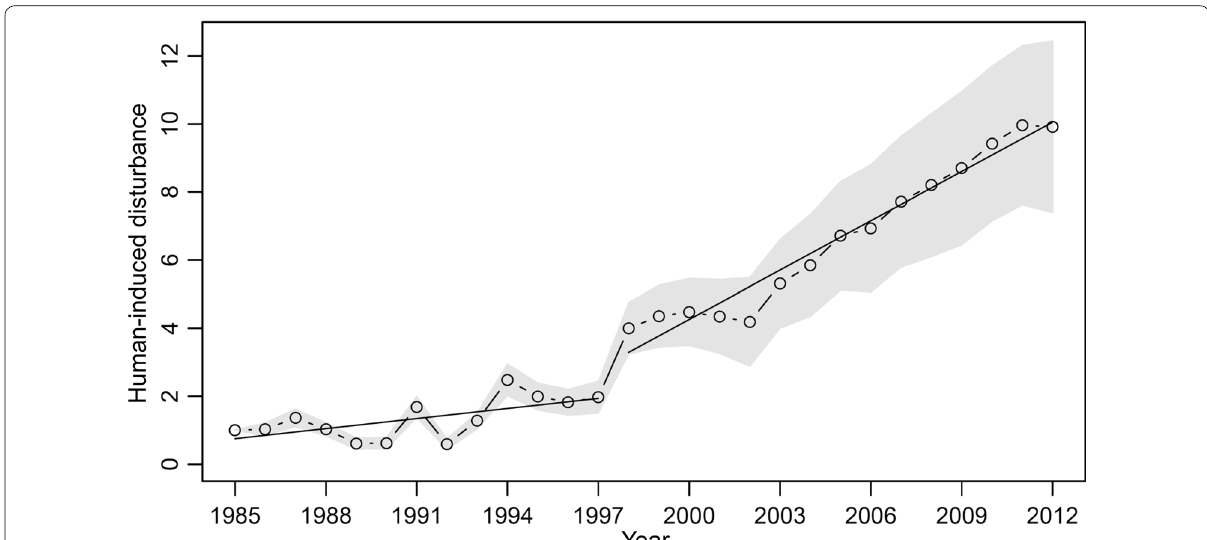
Fig. 4 Temporal variations in the posterior mean and the gray band that corresponds to the standard deviation ( human-induced disturbance to seaweed in Japan from 1985 to 2012. The straight lines represent the simple linear regression lines. The value in the initial year was set to 1